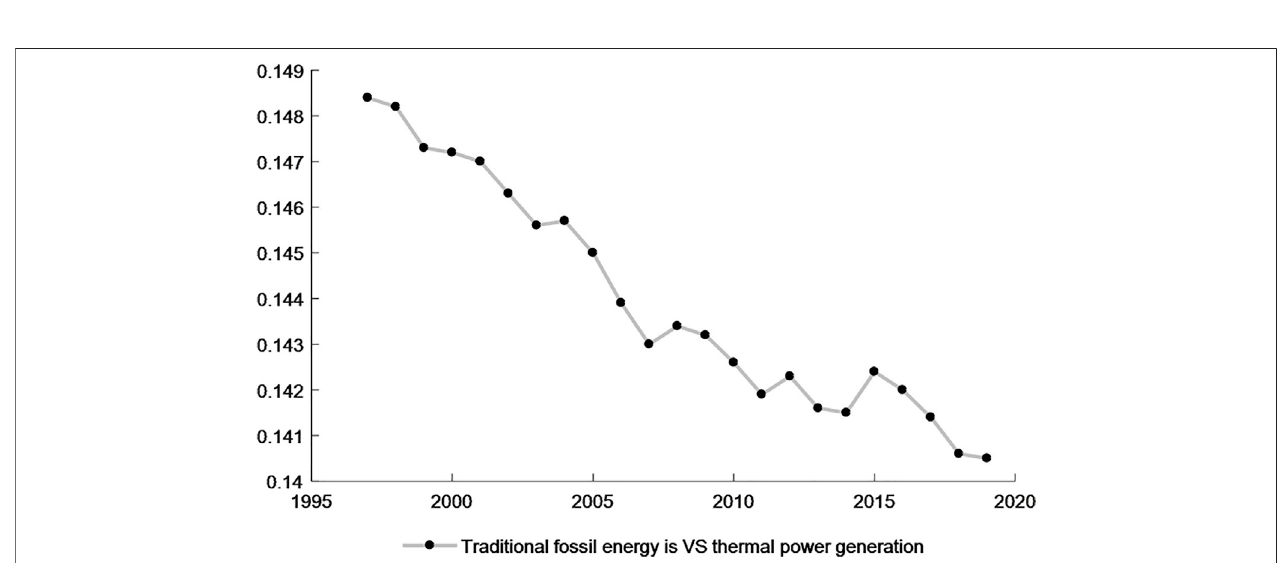
FIGURE 5 | Technical change bias between N and F